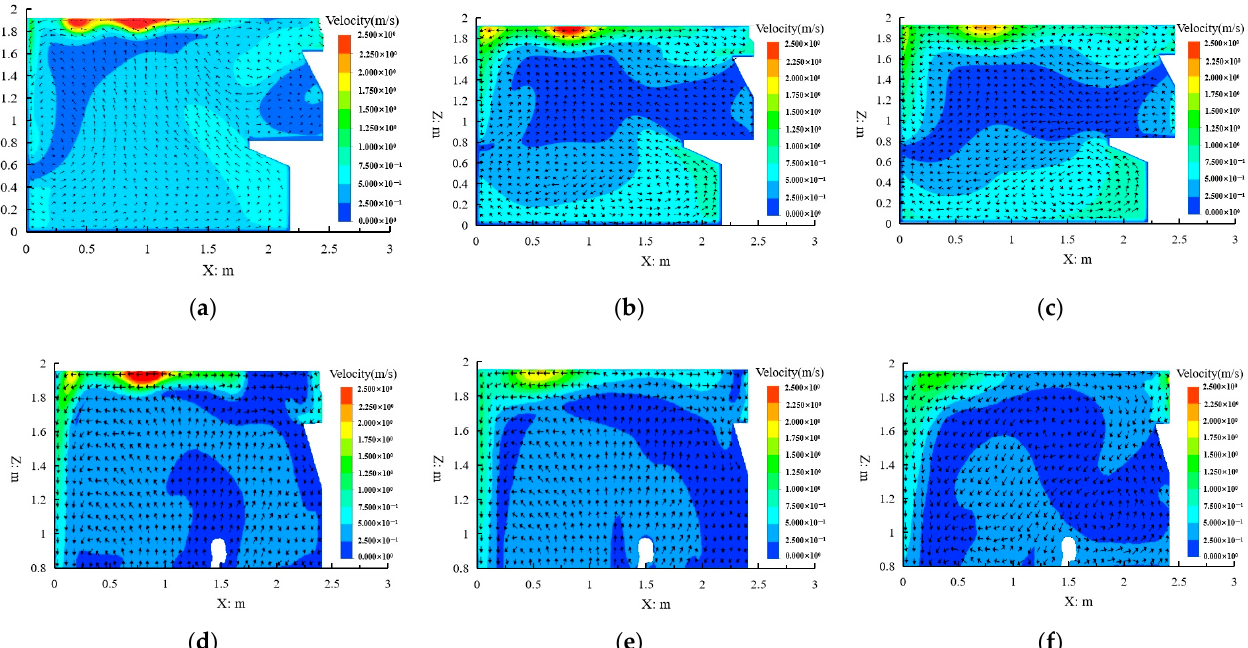
Figure 21. Split diagram of speed vector for manned/unmanned experiments. ( a ) Surface 1 of unmanned; ( b ) surface 2 of unmanned; ( c ) surface 3 of unmanned; ( d ) surface 1 of manned; ( e ) surface 2 of manned; ( f ) surface 3 of manned.